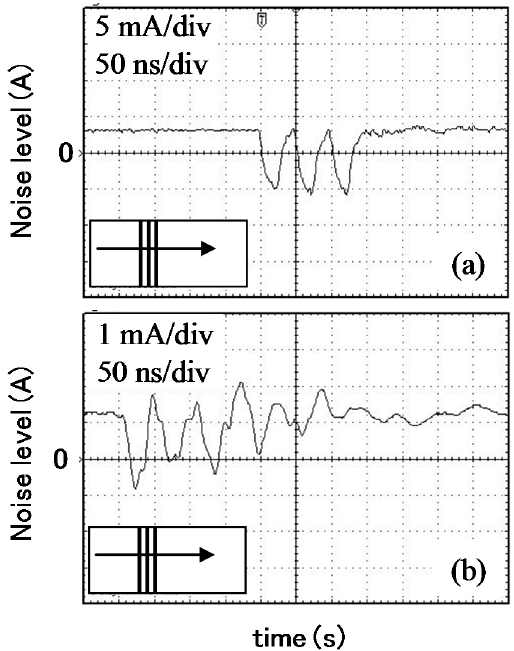
Figure 4. Waveforms of the noise level for: ( a ) normal-mode, ( b ) common-mode.